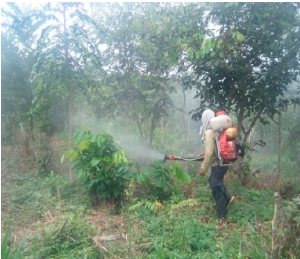
Figure 13. Application of entomopathogens in the planted timber species.